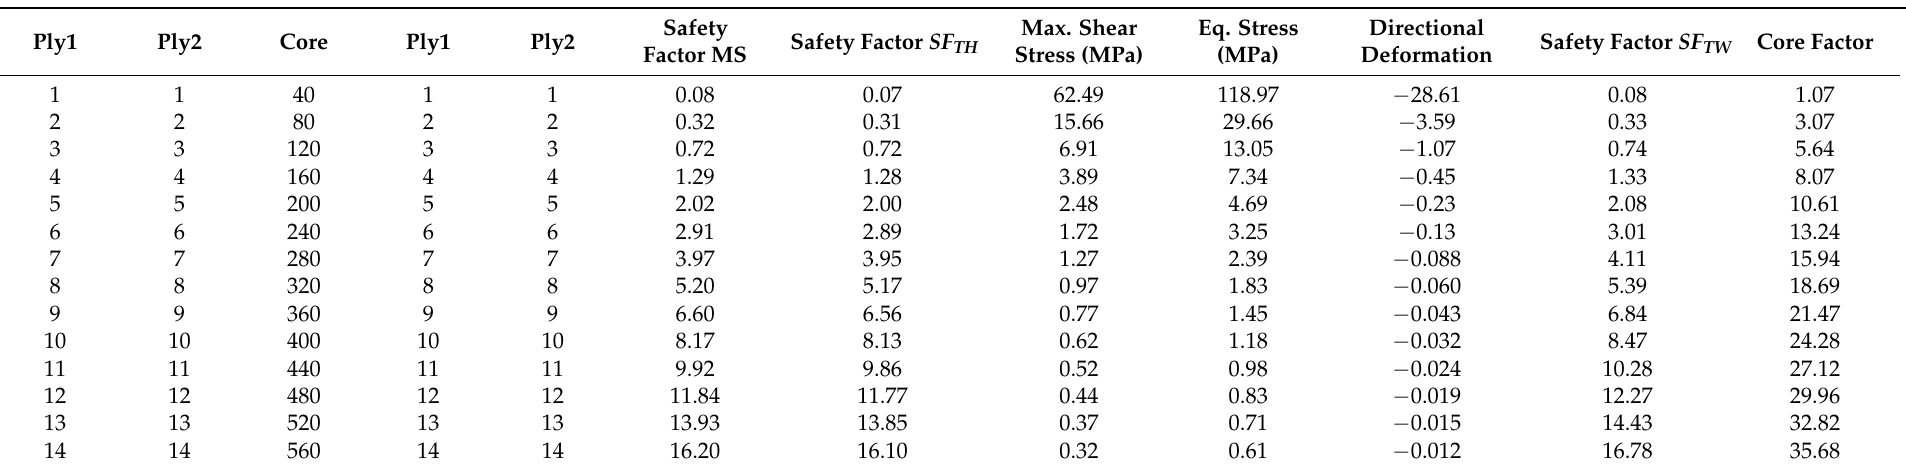
Table 5. Results of the bridge structure with Paulownia